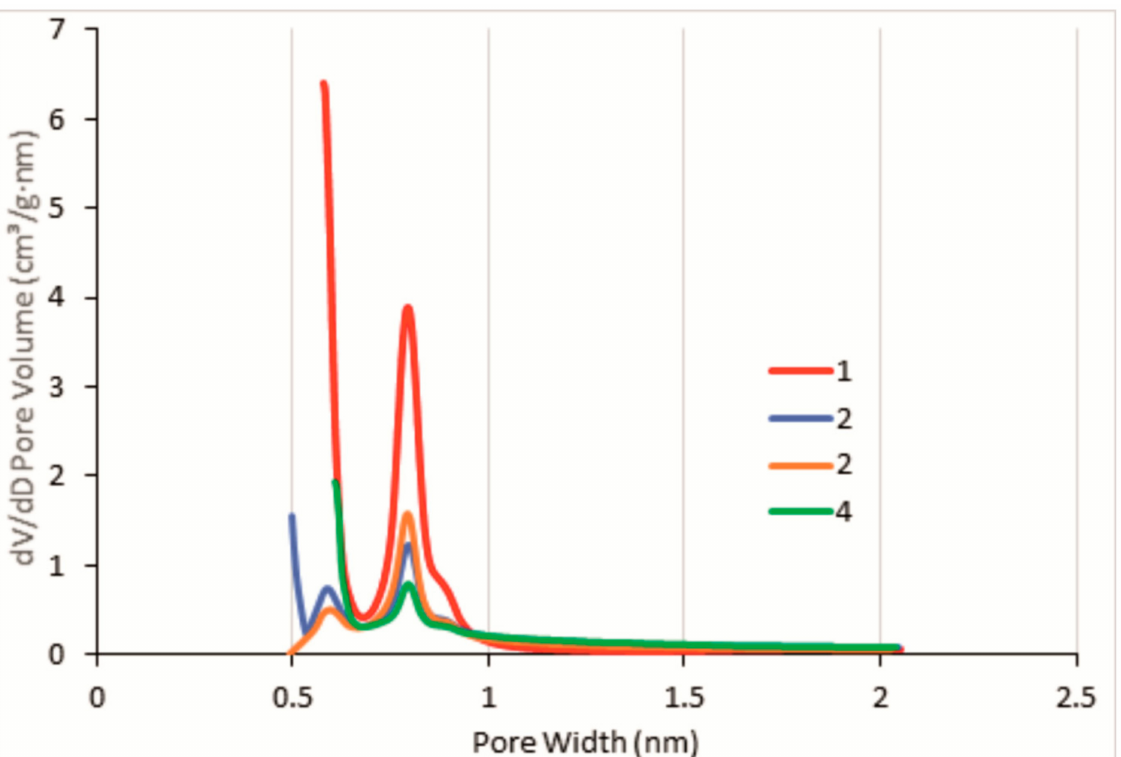
Figure 6. Micropore size distribution calculated by the Horvath–Kawazoe method for the HKUST- 1@BPS composites and HKUST-1 mw reference